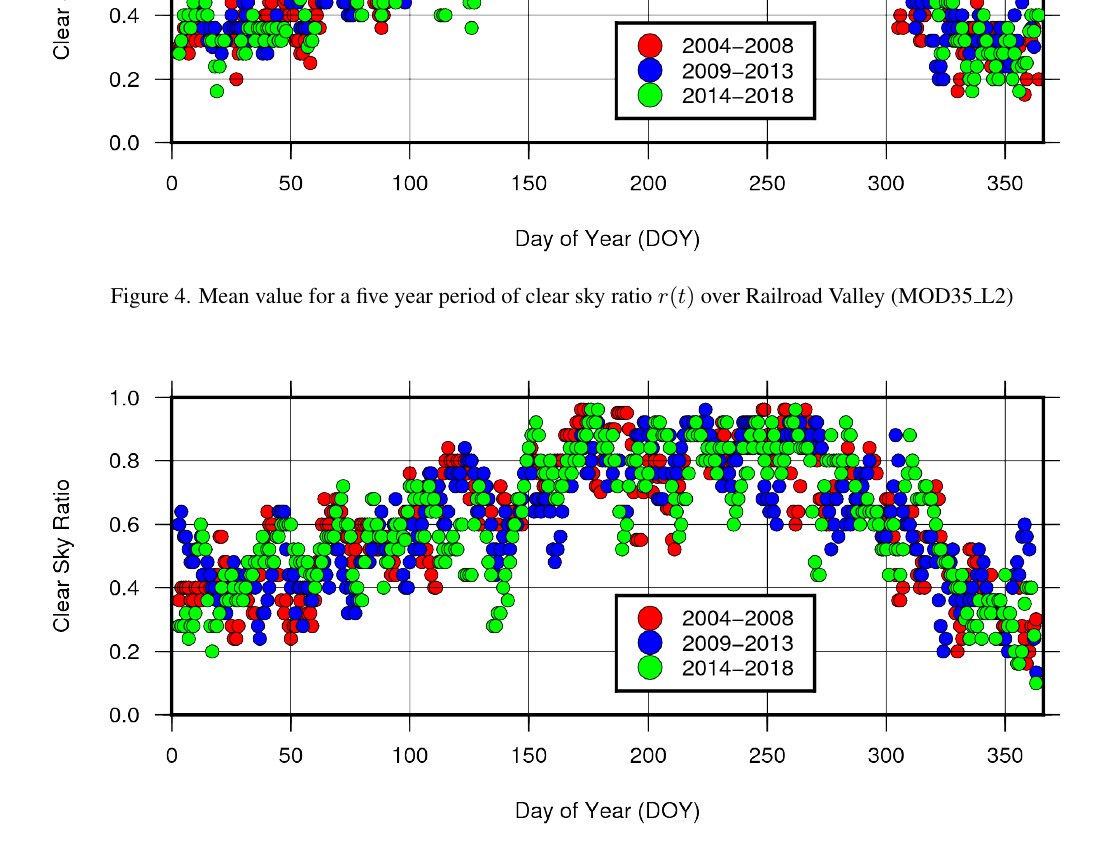
Figure 5. Mean value for a five year period of clear sky ratio r ( t ) over Railroad Valley (MYD35